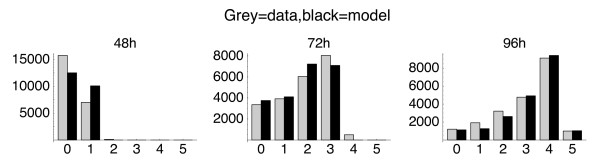
Estimating parameters from T cell proliferation data. The best fit of a heterogeneous discrete-time branching process model to a CFSE timecourse obtained by in vitro stimulation of 2.5 × 104 human CD8+ T cells with anti-CD3 and anti-CD28 in saturating quantities of IL-2. γ refers to division probability, α to death. Cells from independent cultures were recovered and analysed for CFSE content at 24 h intervals after stimulation. The histograms show total cell numbers in each generation (grey bars, observed counts obtained by the EM algorithm; black bars, predicted counts with best-fit branching process model). The best fit model gave a timestep of 12 h and indicated that division (γ) and death (α) probabilities changed with generation number (Table 2).